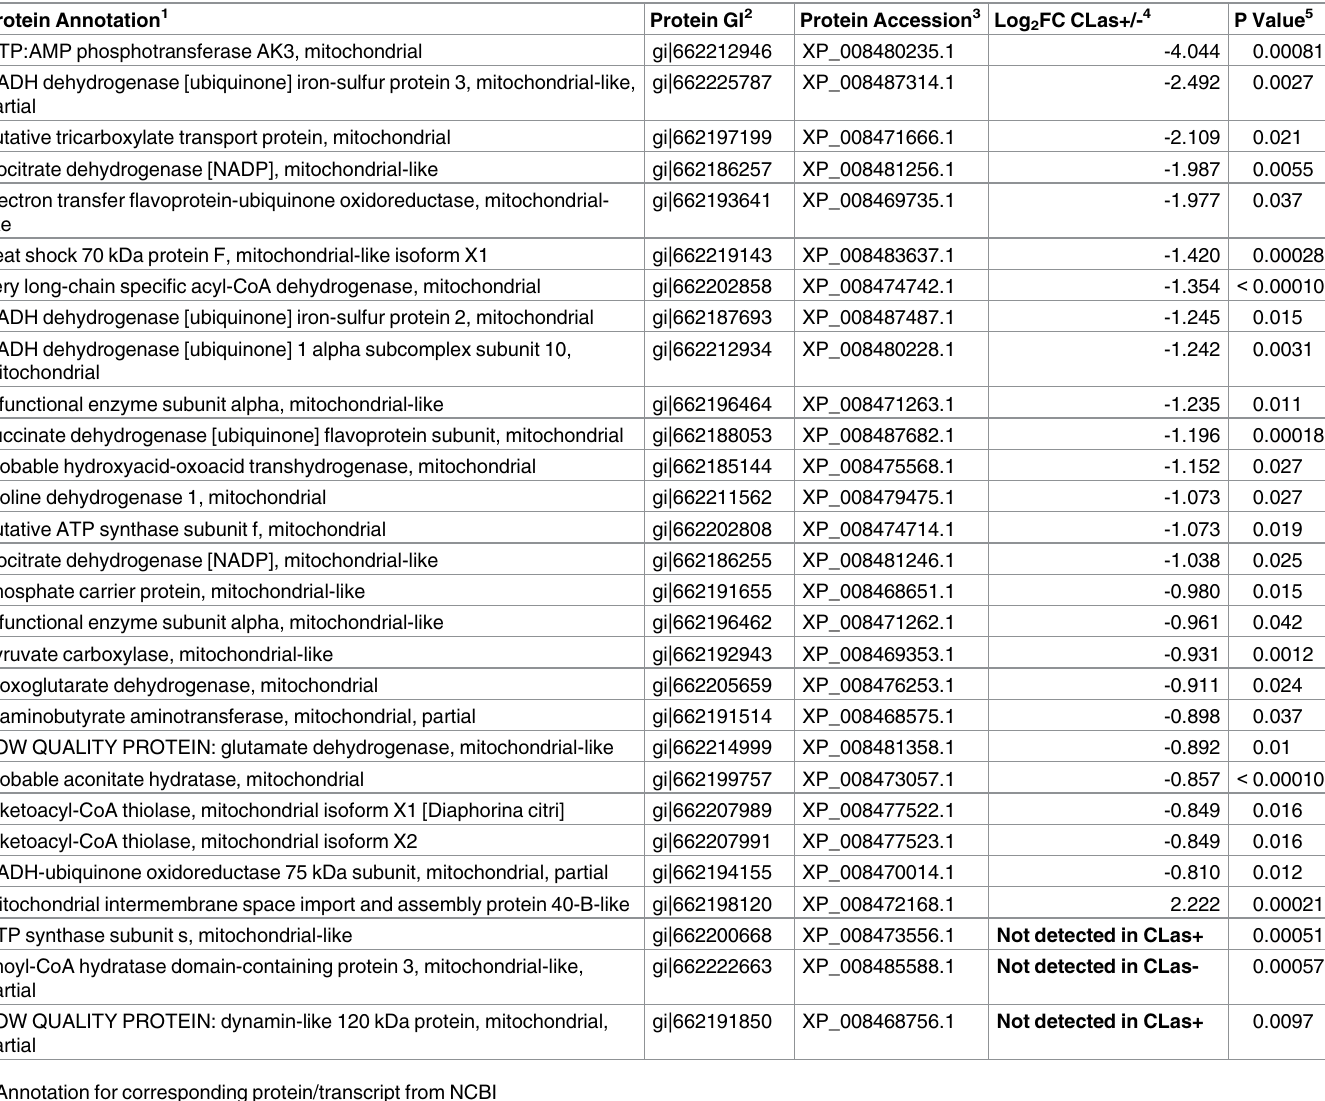
Table 5. Mitochondrial proteins differentially expressedin the ACP